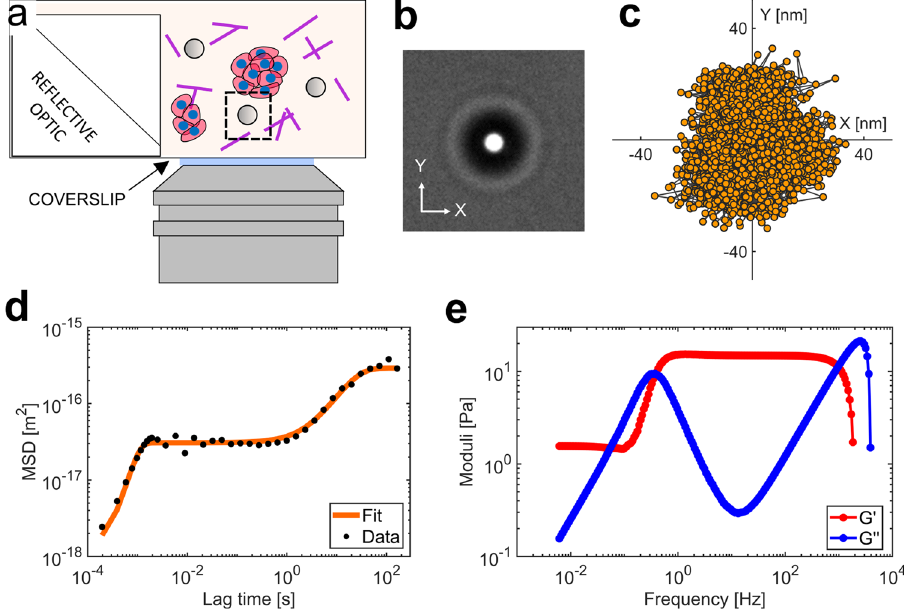
Fig. 3 Passive microrheology without optical trapping. a A schematic representation of passive microrheology measurements. b Microsphere probes (6 μ m diameter) were seeded in the hydrogel and small regions of interest around them (typically 14 μ m × 14 μ m as shown) were imaged at a high frame rate (5 kHz in this example). c Particle trajectory in a 2D plane with individual positions depicted in orange (down sampled here for clarity from a total of 1.5 × 10 6 frames). d , e The mean squared displacement (MSD) provides a measure of gel compliance, which is then used to compute the elastic ( G 0 ð ω Þ ) and viscous ( G 00 ð ω Þ ) moduli of the gel over a wide range of frequencies as shown in ( e ) (for more details on the analysis see